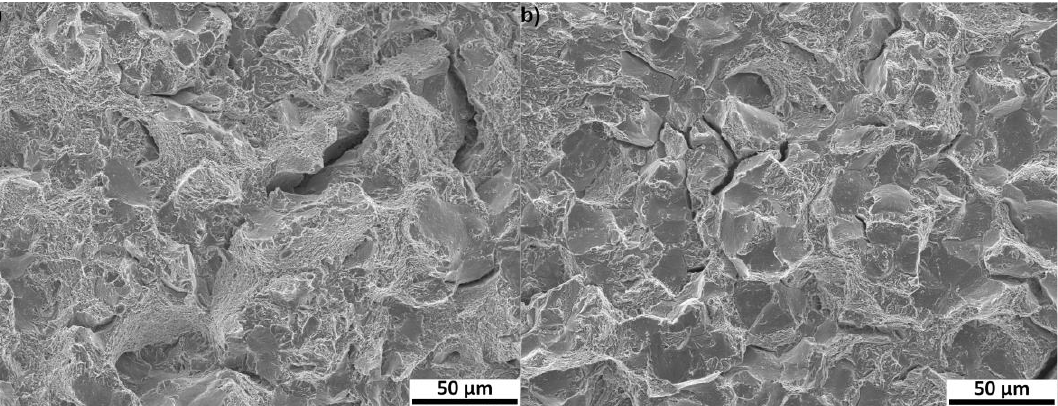
Figure 3. Charpy impact test fracture surfaces of samples after tempering for 24 h: 0 Cu steel ( a ) and 1.5 Cu steel ( b ) observed by SEM in a secondary electrons mode (SE).